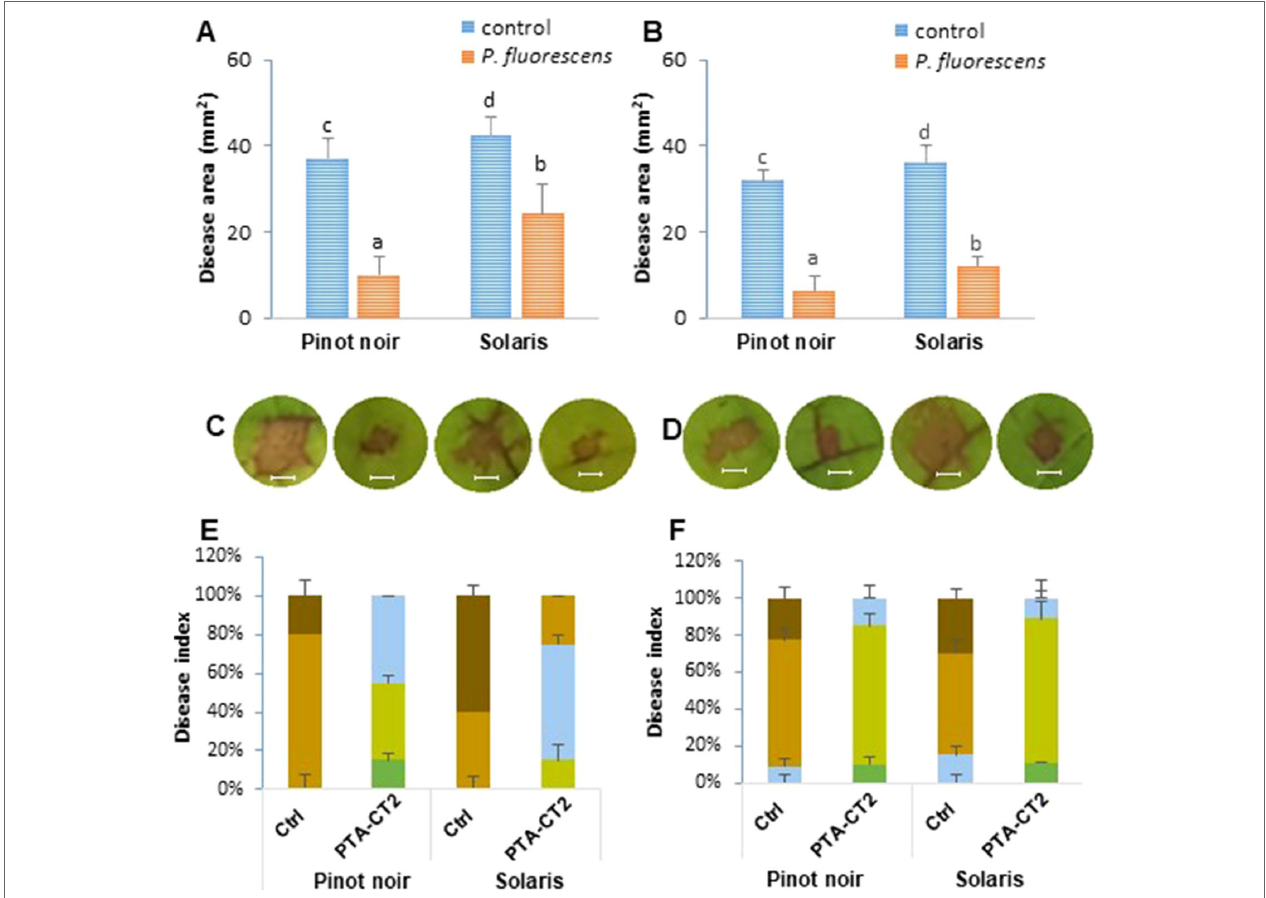
FIGURE 5 | Pseudomonas fluorescens PTA-CT2 induces systemic resistance against Botrytis cinerea in Pinot noir and Solaris cultivars. Plants were treated at the root level with P. fluorescens at 10 7 CFU g −1 of soil, and 2 weeks later, leaf disks were excised from the upper third and fourth leaves and infected with 5 µl of 10 6 conidia per milliliter of B. cinerea . Necrotic lesion sizes were evaluated at 7 dpi by Compu Eye, Leaf & Symptom Area (LSA) software (A, B) . Photographs (C, D) depict the representative disease symptoms on leaf disks of control and PTA-CT2-treated plants at 7 dpi. Bars = 4 mm. Disease index (E, F) was expressed as the fraction of leaf disks falling in the following classes: dark green, no visible symptom; light green, lesion covering 5–10 mm 2 ; blue, lesion covering 10–20 mm 2 ; light brown, lesion covering 20–40 mm 2 ; dark brown, lesion covering more than 40 mm 2 of the leaf disk area. Data are the means from three independent